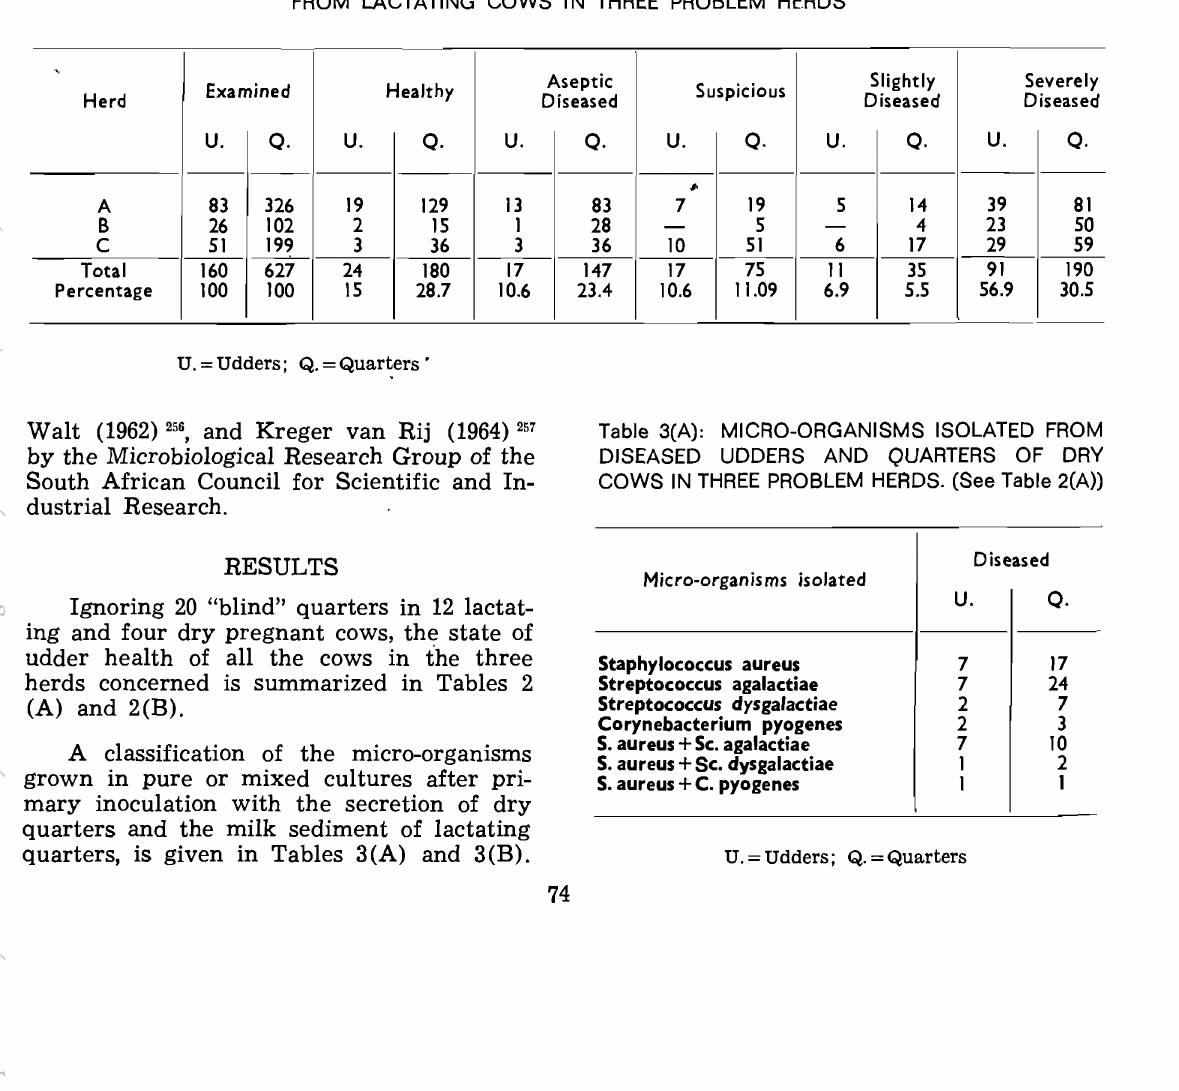
• Tab,le. 2(B): DISTRIBUTION OF RESULTS OF LABORATORY EXAMINATION OF QUARTER MILK SAMPLES FROM LACTATING COWS IN THREE PROBLEM HERDS